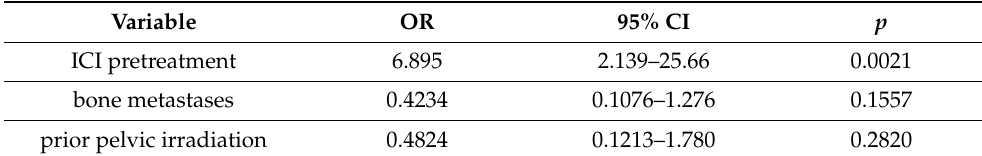
Table 5. Multivariable logistic regression analysis of considerable treatment effect (SD, PR, or CR) in all patients.